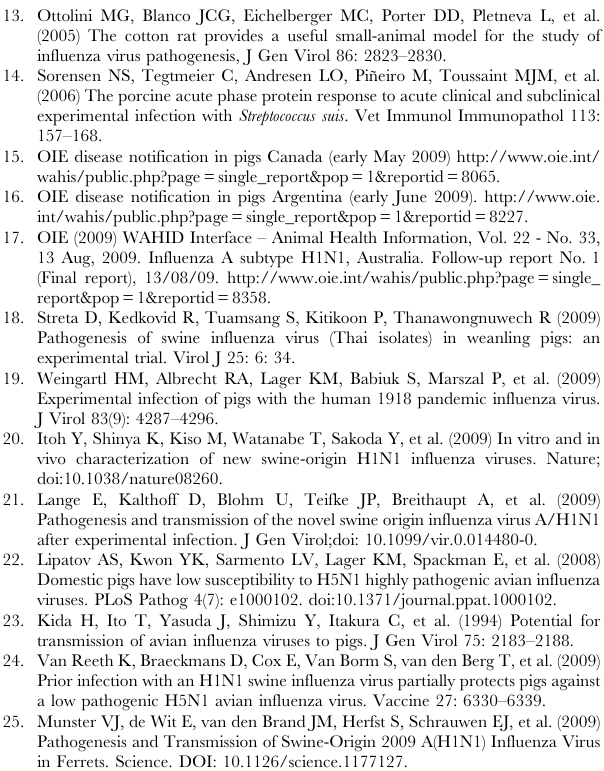
Figure S4 Semi-quantitative nasal H1N1/09v virus shedding (REU log10; mean + SE) from infected (INF, panel A) and transmission cycle (TC, panels B–E) pigs. Panel F is the combined data (A–E).